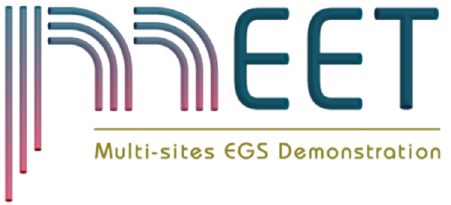
Figure 1. Logo of the MEET project, URL (https://www.meet-h2020.com (accessed on 1 September 2022)) of its website and that of the platform (https://zenodo.org/communities/eu_project_meet/ (ac- cessed on 1 September 2022)) on which all of the documents produced by the MEET project are stored.